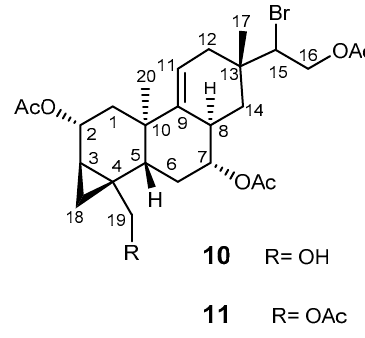
Figure 2. The structures of parguerene I ( 10 ) and II ( 11 ).